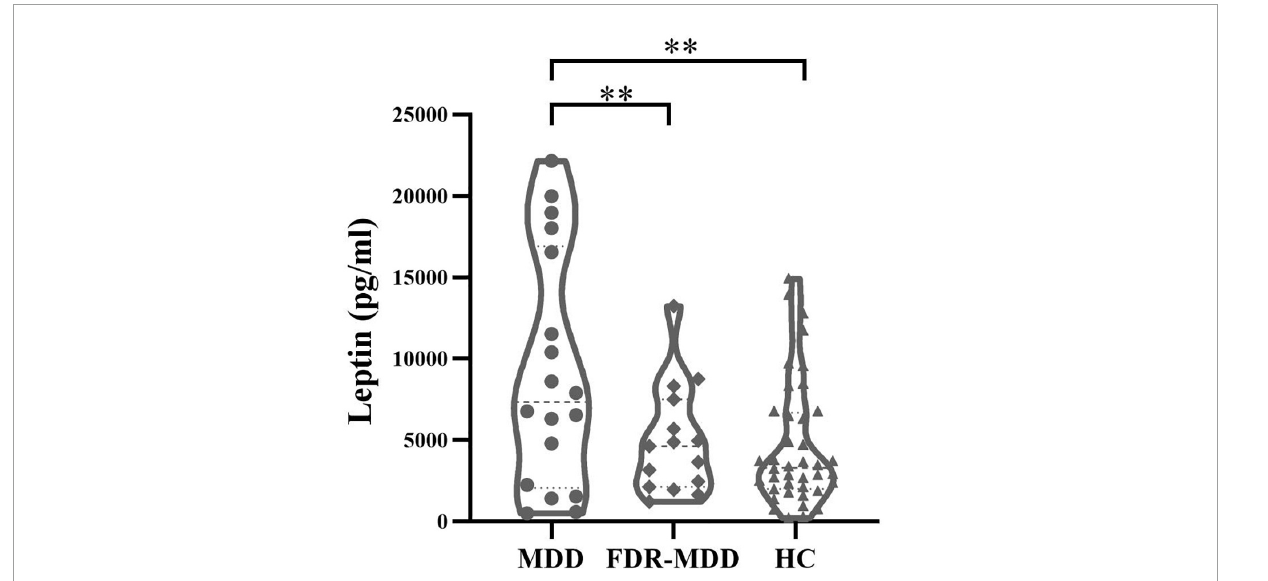
FIGURE1 Comparison of plasma leptin levels by groups. Higher plasma leptin levels in drug-naïve MDD (9,163.11 ± 7,184.88 pg/ml) compared with FDR-MDD (4,956.07 ± 3,320.44 pg/ml, p = 0.003) and HC (4,633.3 ± 3,836.81 pg/ml, p = 0.008) after Bonferroni correction. ** p <